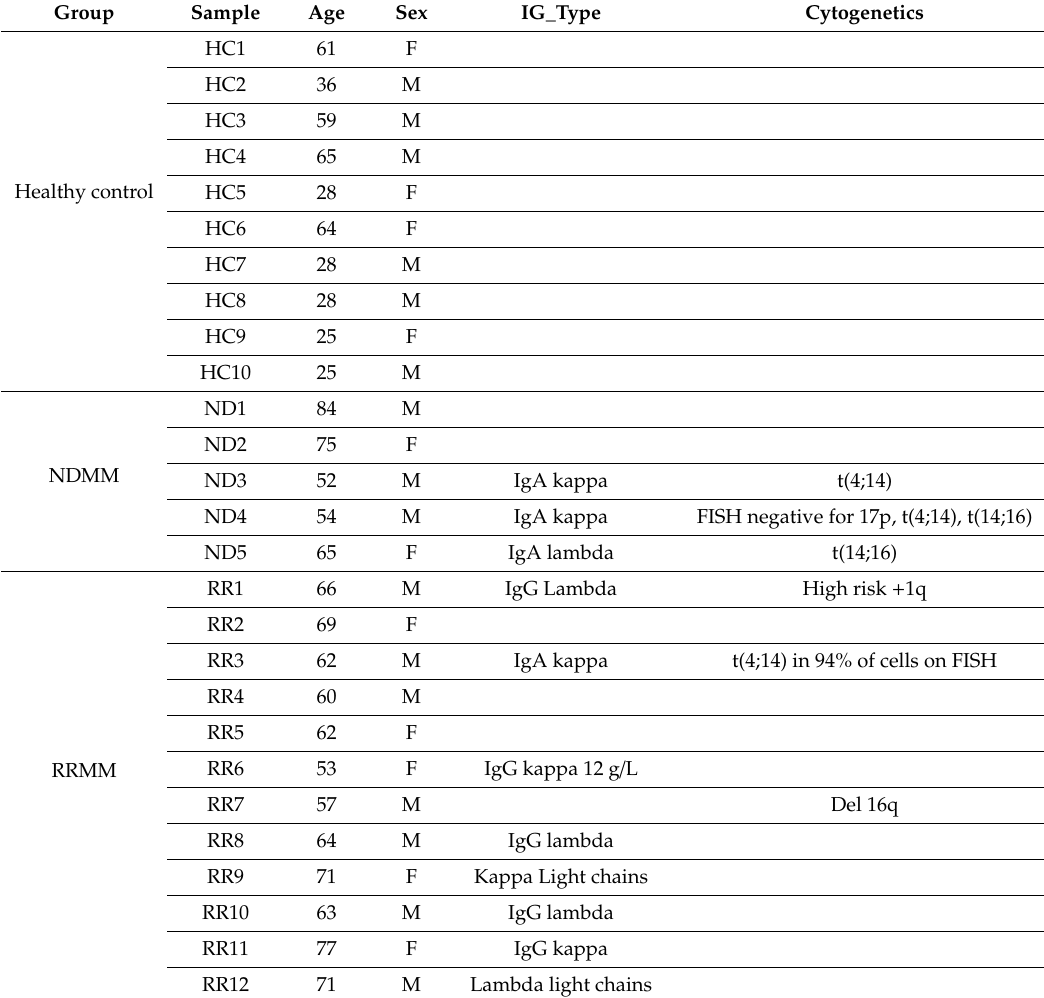
Table 1. Description of participants in this study. No bias was found in age or sex in the participants for each group. HC: healthy control; ND: newly diagnosed MM patient; RR: relapsed and refractory MM patient; IgA: immunoglobulin A; FISH: fluorescence in situ hybridization. Translocation t(4:14) represents the FGFR3-IGH fusion event while t(14:16) represents the IGH-MAF fusion event. Group Sample Age Sex IG_Type Cytogenetics